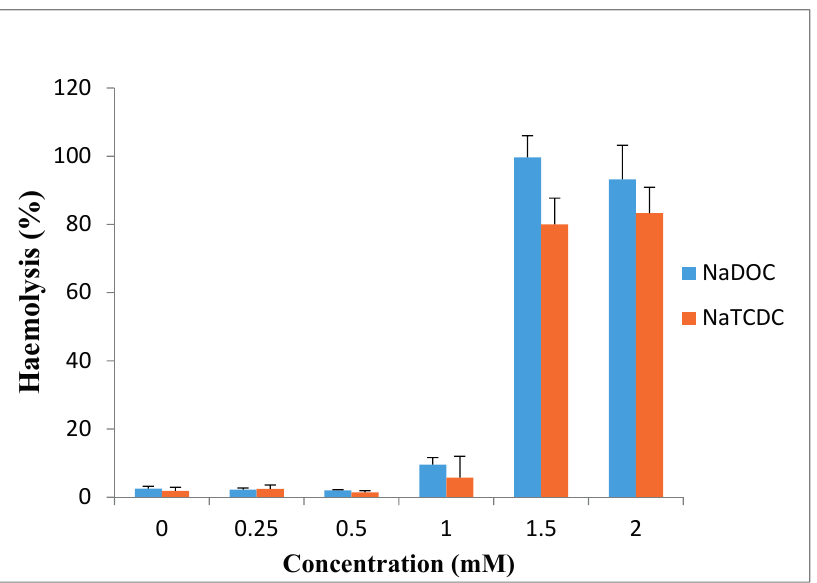
Figure 7. Percentage haemolysis of red blood cells caused by incubation with